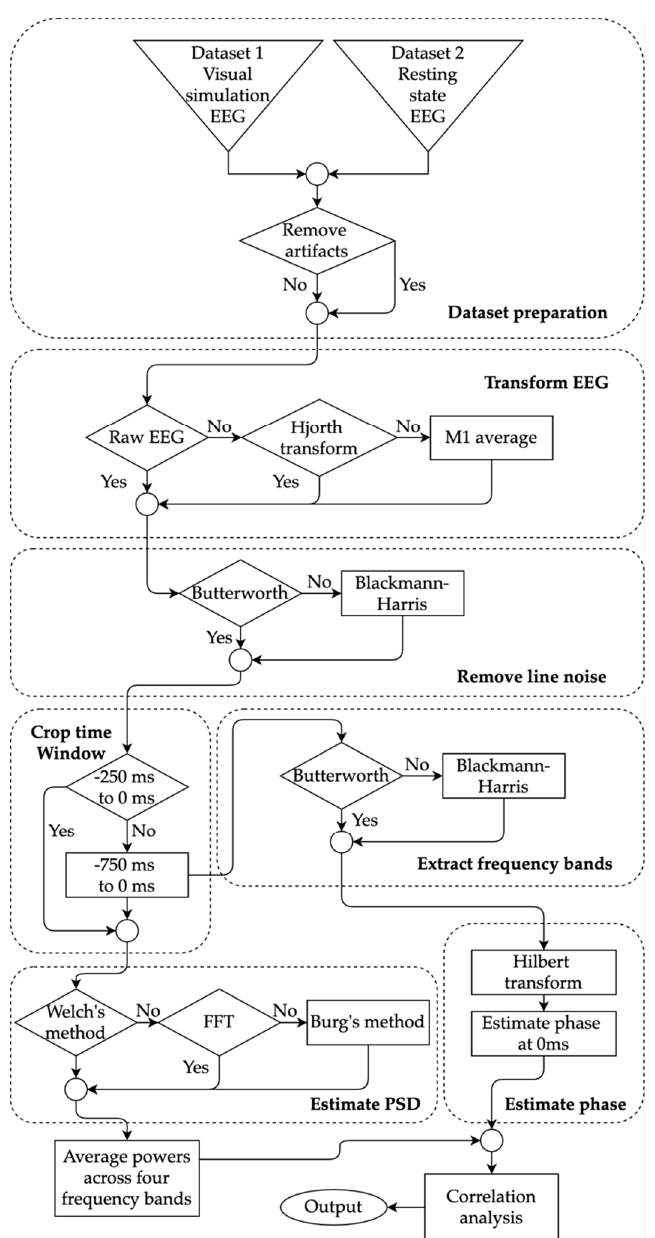
Figure 1. Flow diagram of the processing methods carried out to estimate powers and phases for four frequency bands. The selection choices of fives methods were explored highlighted with diamond shape: artifact removal, electroencephalogram (EEG) transformation, filtering, time window selection, and power spectral density (PSD) estimation. The estimated powers and phases were used to find the correlation between the choices.